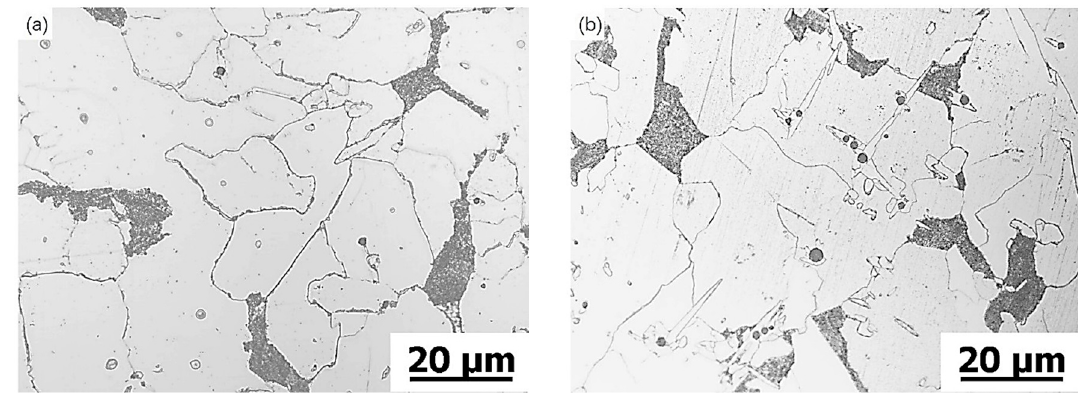
Figure 7. Optical micrographs of ingot samples with different alloy adding sequences: ( a ) Al–Ti–Mg; and ( b )